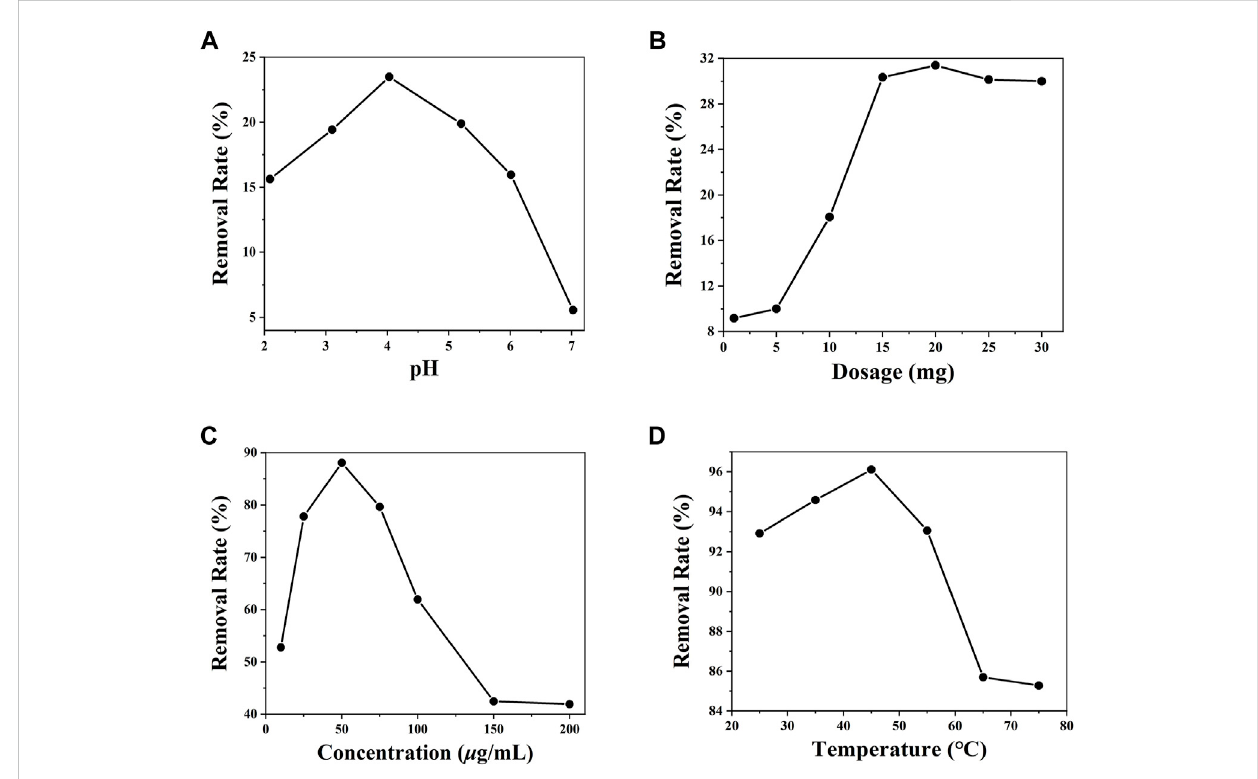
FIGURE 2 In fl uence of different pH (A) , dosages (B) , initial concentrations of the Cr(VI) ion, (C) and temperatures (D) on the removal by DUT-67